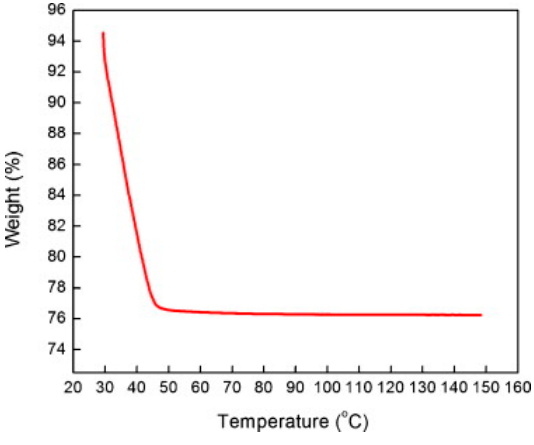
Figure 17. Thermal gravimetric analysis (TGA) results of TiO 2 . Reproduced with permission from [51].